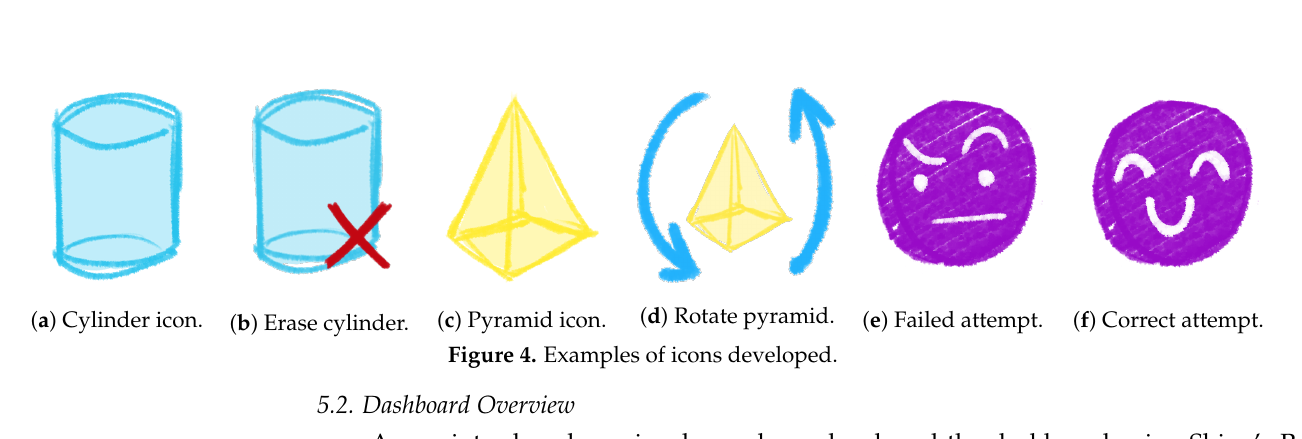
Figure 4. Examples of icons developed.